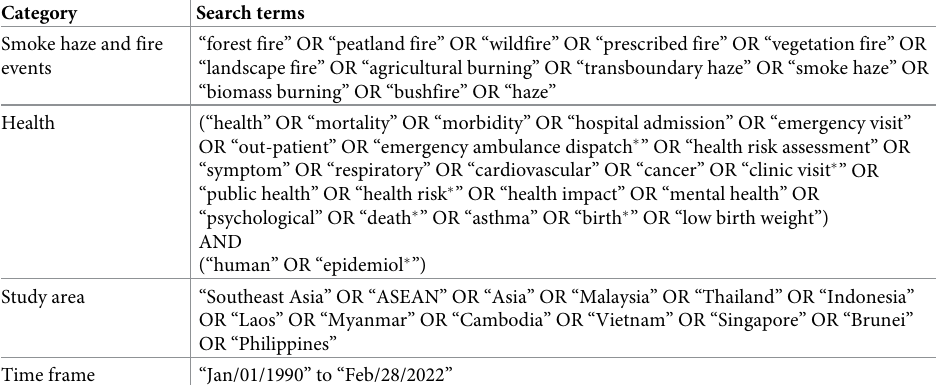
Table 1. Search terms by